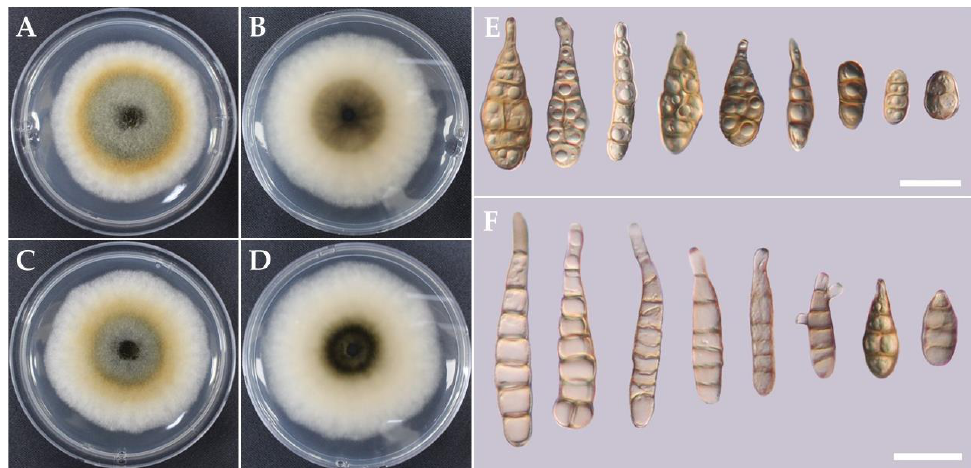
Figure 5. Obverse and reverse colony characteristics of CMML20 – 7 and CMML20 – 8 isolates on PDA at 25 °C for 7 days ( A – D ). Different conidial sizes and shapes are observed under the microscope ( E , F ). Scale bars ( E , F ) = 20 μm.